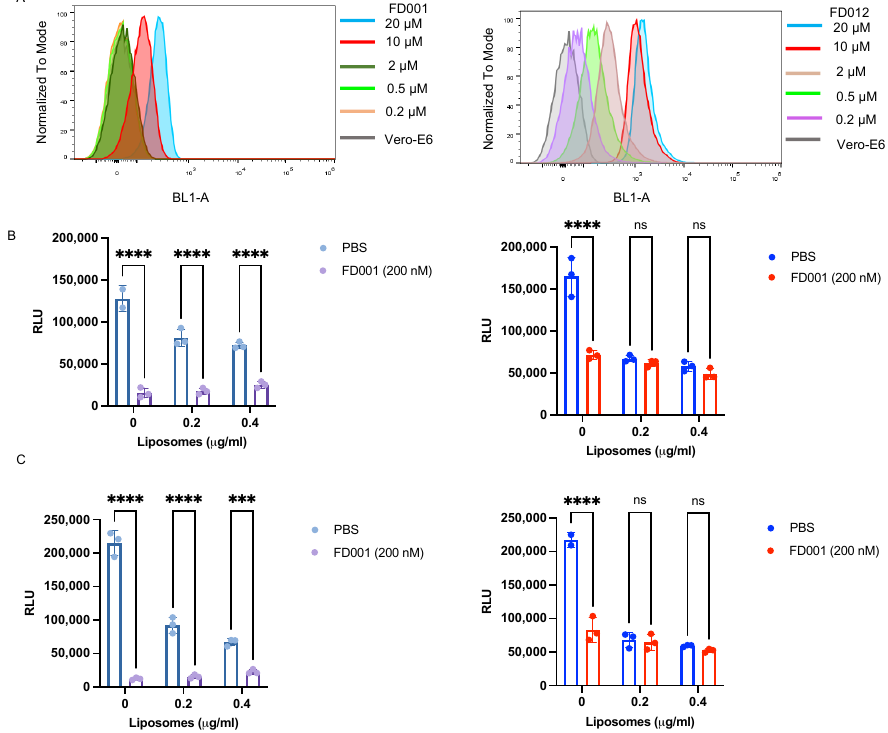
Figure 5. FD-compounds may target the lipid membrane of the enveloped virus. ( A ) FD-compounds bind to Vero E6 cells in a concentration-dependent manner; ( B ) HIV-1 Bal.01 PsVs were pretreated with FD001, and then added into target cells in the presence of recombinant unilamellar liposomes (size = 400 nm, 8:2 molar ratio of phosphatidylcholine (PC) to cholesterol) ( left ), while FD001 was pre- treated with unilamellar liposomes (400 nm) and virus successively, and then added into target cells ( right ); ( C ) the liposome size was 100 nm, and the other conditions were the same as in B. Two-way ANOVA was used in the statistical analysis. **** and *** mean p <0.0001 and p <0.001,